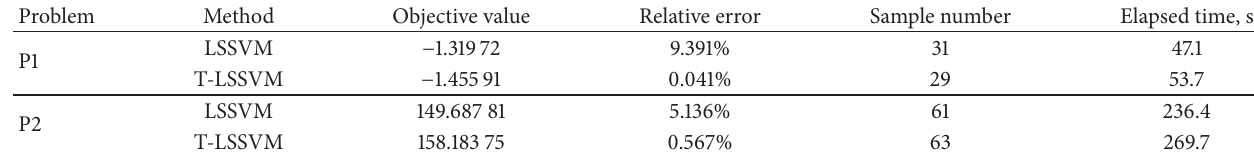
Table 3: Numerical experiment results using LSSVM and T-LSSVM.